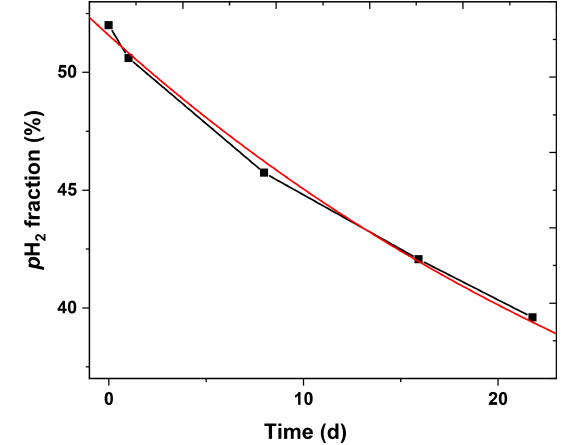
Figure 9. p H 2 lifetime in a 2L aluminium cylinder. After produc- tion, five samples of p H 2 were taken from the cylinder (days 0, 1, 7, 15 and 21) and quantified (squares). An exponential func- tion A 1 · exp( − t/τ ) + y 0 with y 0 = 25 (red line) was fitted to the data and yielded A 1 = 26 . 6 ± 0 . 3 and a decay constant of τ = (35 . 5 ± 1 .